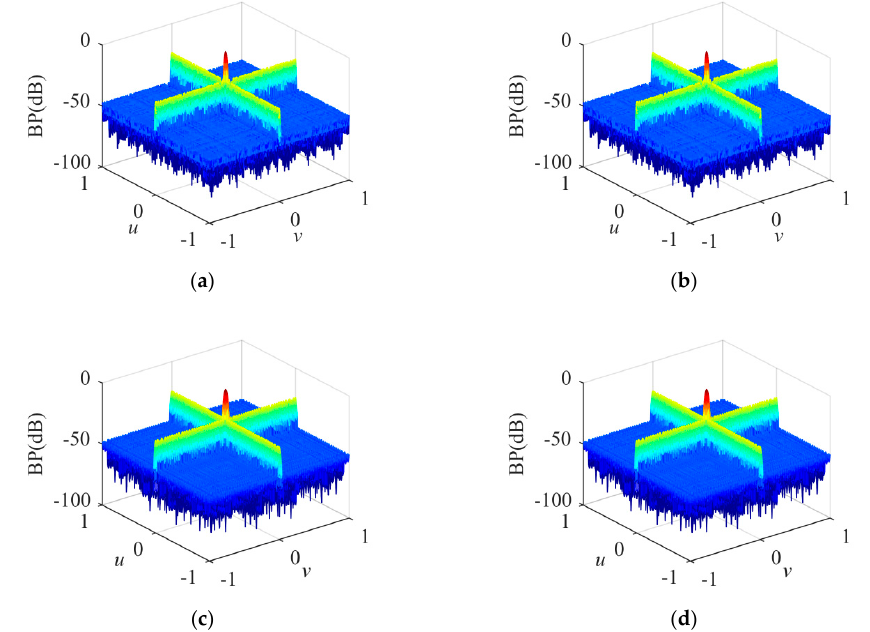
Figure 7. BPs of sparse cross array. ( a ) δ = 0, transmitting frequency = 300 kHz; ( b ) δ = 0.083, transmitting frequency = 300 kHz; ( c ) δ = 0, transmitting frequency = 205 kHz;( d ) δ = 0.083, transmitting frequency = 205